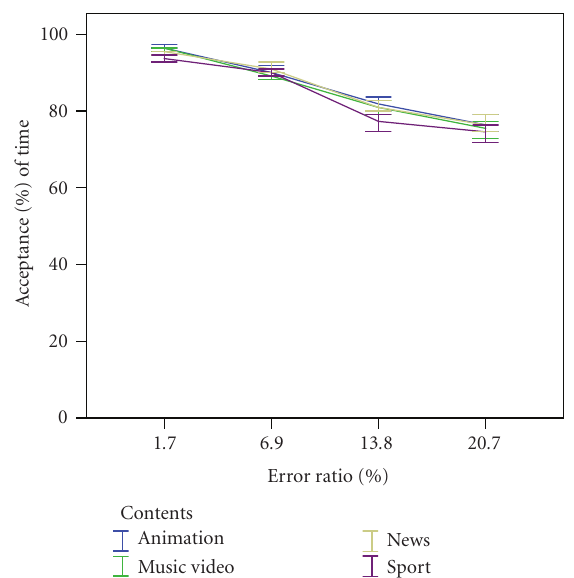
Figure 7: Relations on the scale between retrospective acceptance and satisfaction; and retrospective acceptance and acceptance based on continuous assessment. Bars show mean and standard